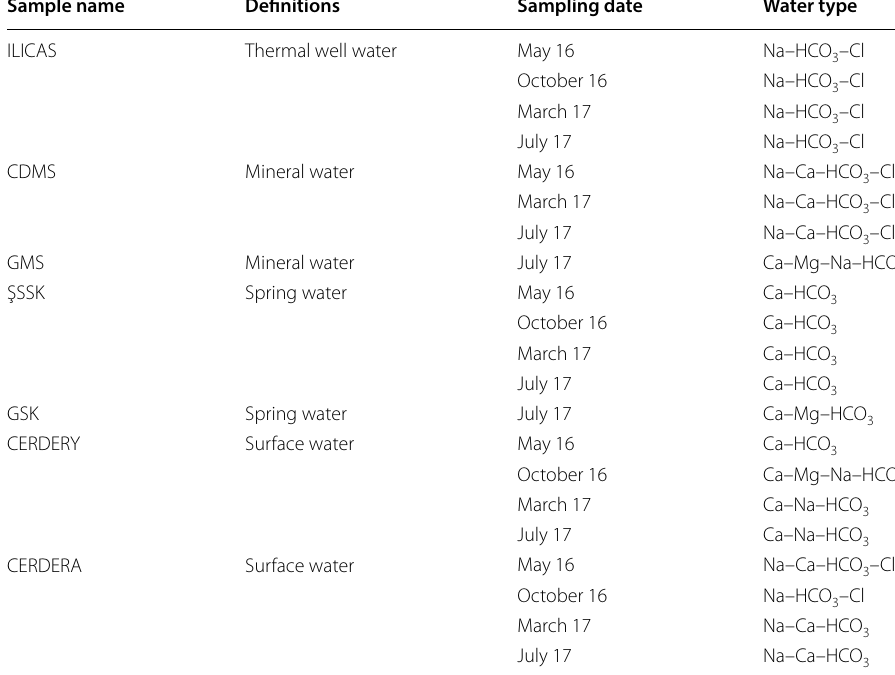
Table 3 Classification of the waters in Şavşat Geothermal Field according to IAH